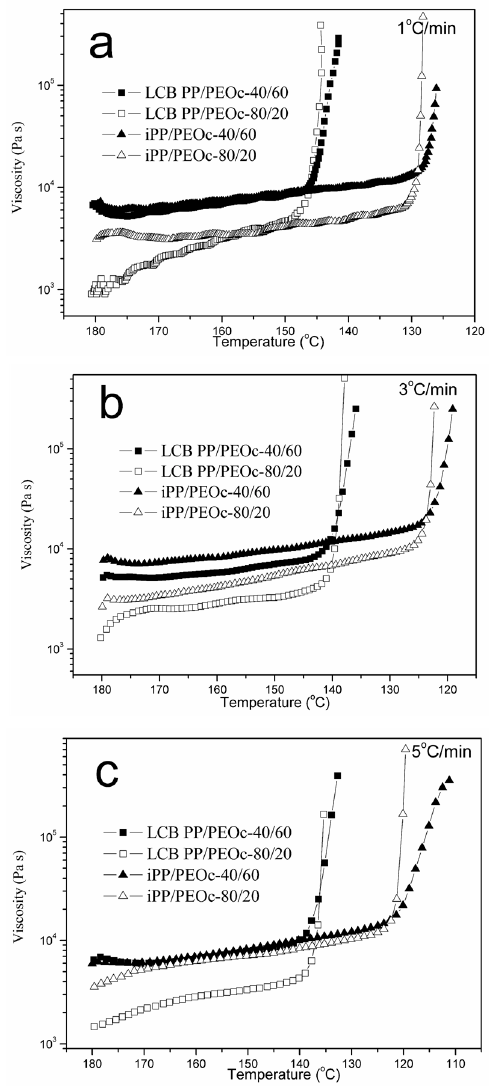
Figure 9. Viscosity development curves of LCB PP/PEOc and iPP/PEOc blends at the cooling rates of ( a ) 1 °C min − 1 ; ( b ) 3 °C min − 1 ; and ( c ) 5 °C min − 1 , at a shear rate = 0.1 s − 1 .